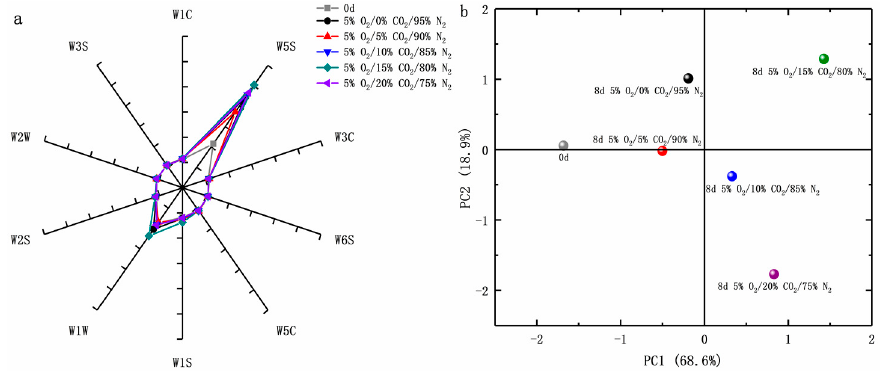
Figure 7. Effect of CO 2 concentration (%) with 5% O 2 on radar fingerprint charts ( a ), and principal component analysis ( b ) of fresh-cut Dictyophora rubrovolvata . Differences at p < 0.05 are indicated by different letters and data are expressed as the mean ± SD.